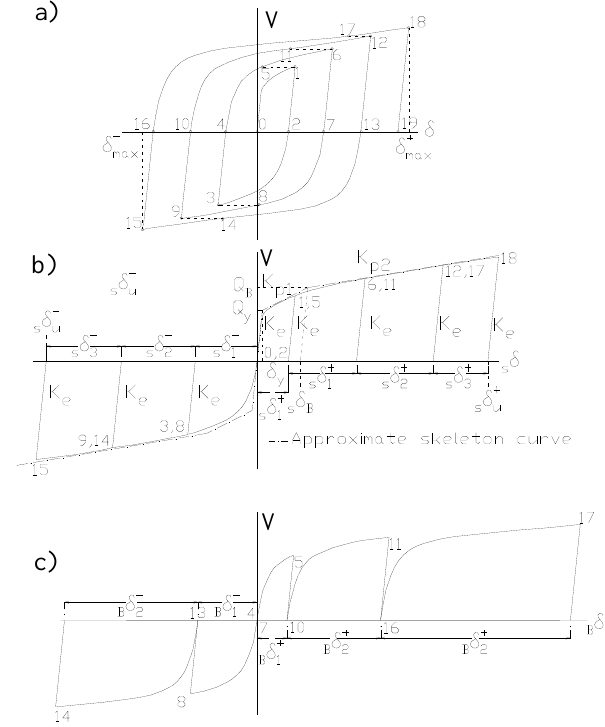
Figure 11. Decomposition of a typical V- δ curve: ( a ) initial V- δ curve; ( b ) skeleton part; ( c ) Bauschinger